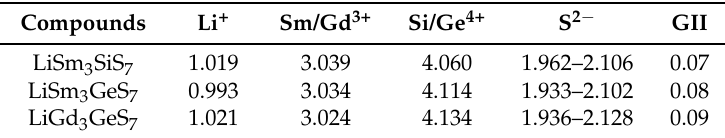
Table 1. Bond valence sum (vu) and global instability index (GII) of title compounds.